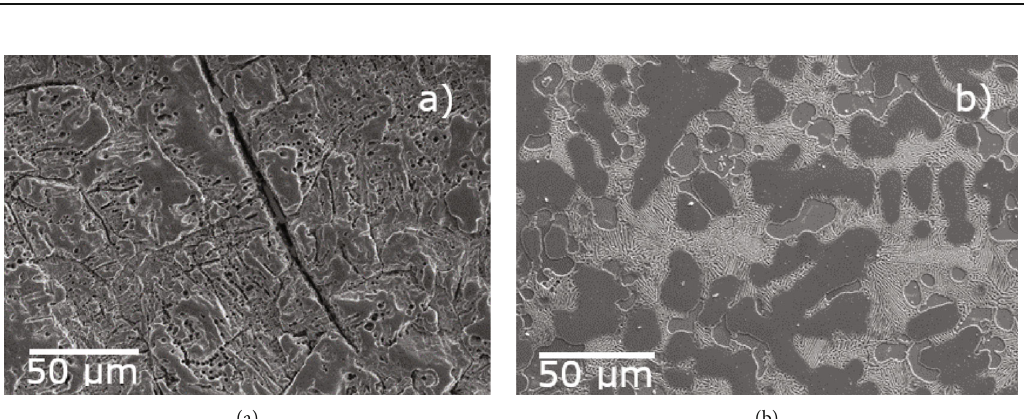
Figure 11: Micrographs recorded for the M1 (a) and M4 (b) aluminum-based alloy doped with Co and